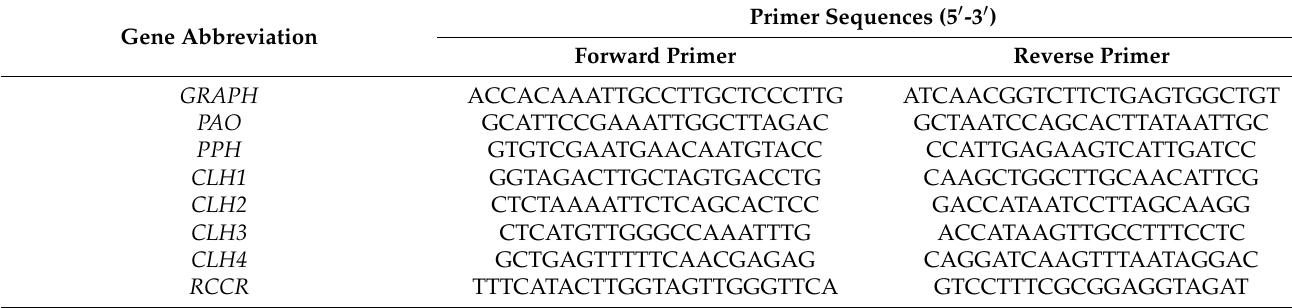
Table 1. Primer sequences (5 (cid:48) -3 (cid:48)